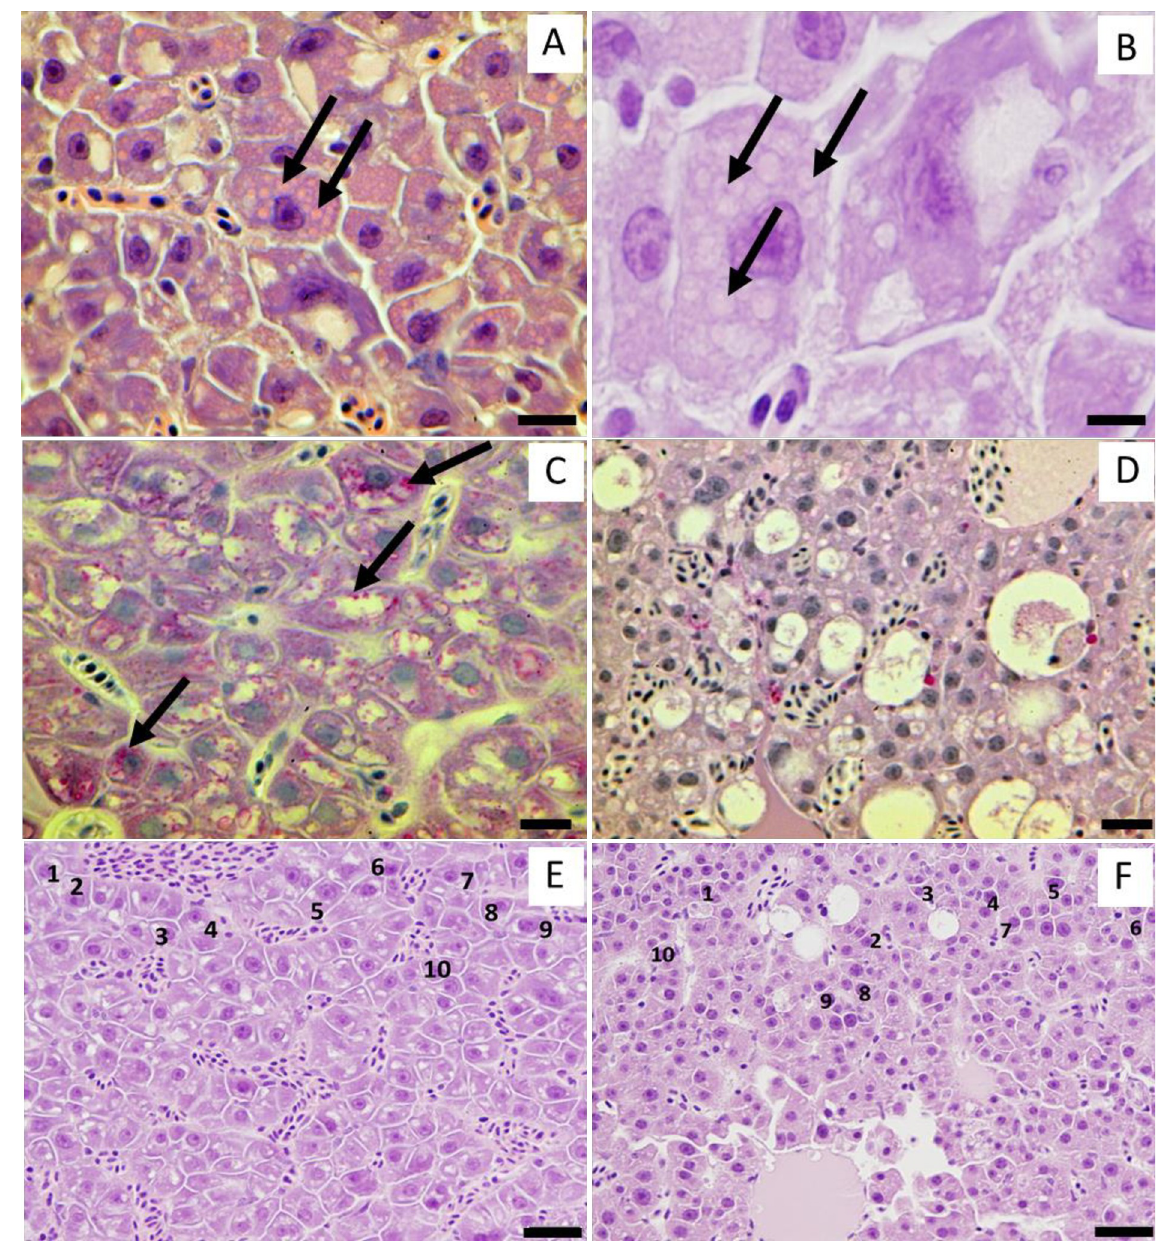
Fig 1. Liver histopathology. Panel A: Liver of Delta Smelt from the No Feeding treatment at Day 4. Arrows indicate eosinophilic cytoplasmic inclusion bodies, possibly autophagosomes. Panel B: Liver of Delta Smelt from the No Feeding treatment at Day 7, cytoplasmic inclusion bodies (indicated by arrows) at higher magnification. Note possible double membranes. Panel C: Liver of Delta Smelt from the Feeding treatment, PAS stain. Arrows indicate glycogen granules in the cytoplasm of hepatocytes that are stained magenta (compare to panel D). Panel D: Liver from Delta Smelt from the No Feeding treatment at Day 21, PAS stain. No magenta glycogen granules observed in cytoplasm of hepatocytes (compare to panel C). Panel E: Liver of Delta Smelt from the Feeding treatment, H&E stain; the numbered hepatocytes were used to measure hepatocyte area. Panel F: Liver of Delta Smelt at Day 21 from the No Feeding treatment, H&E stain. Note atrophied hepatocytes (compare to Panel E). For both the Feeding and No Feeding treatments, hepatocytes were selected for area measurement based on three criteria: 1) well demarcated cell membranes, 2) presence of nucleolus in the nucleus, and 3) cells were along a ‘backward S’ path moving from the top-left corner to the bottom-right corner of each photo (Panels E and F). Scale bars = 20 μ m (Panel A), 8 μ m (Panel B), 15 μ m (Panels C and D), 20 μ m (Panels E and F).Using the formalin-fixed fish, liver tissue from the No Feeding treatment at Day 0, 21, 42, and 56 was prepared for immunohistochemical detection of apoptosis. Liver tissue from two fed fish was used as a control (Day 0 and 49). Tissues for immunohistochemistry were sectioned (3 μ m) and adhered to Superfrost 1 Plus Microscope Slides (Fisher Scientific, Pittsburgh, PA, USA). Copper-exposed olfactory tissue from Delta Smelt was used as positive control and normal horse serum was substituted for the primary